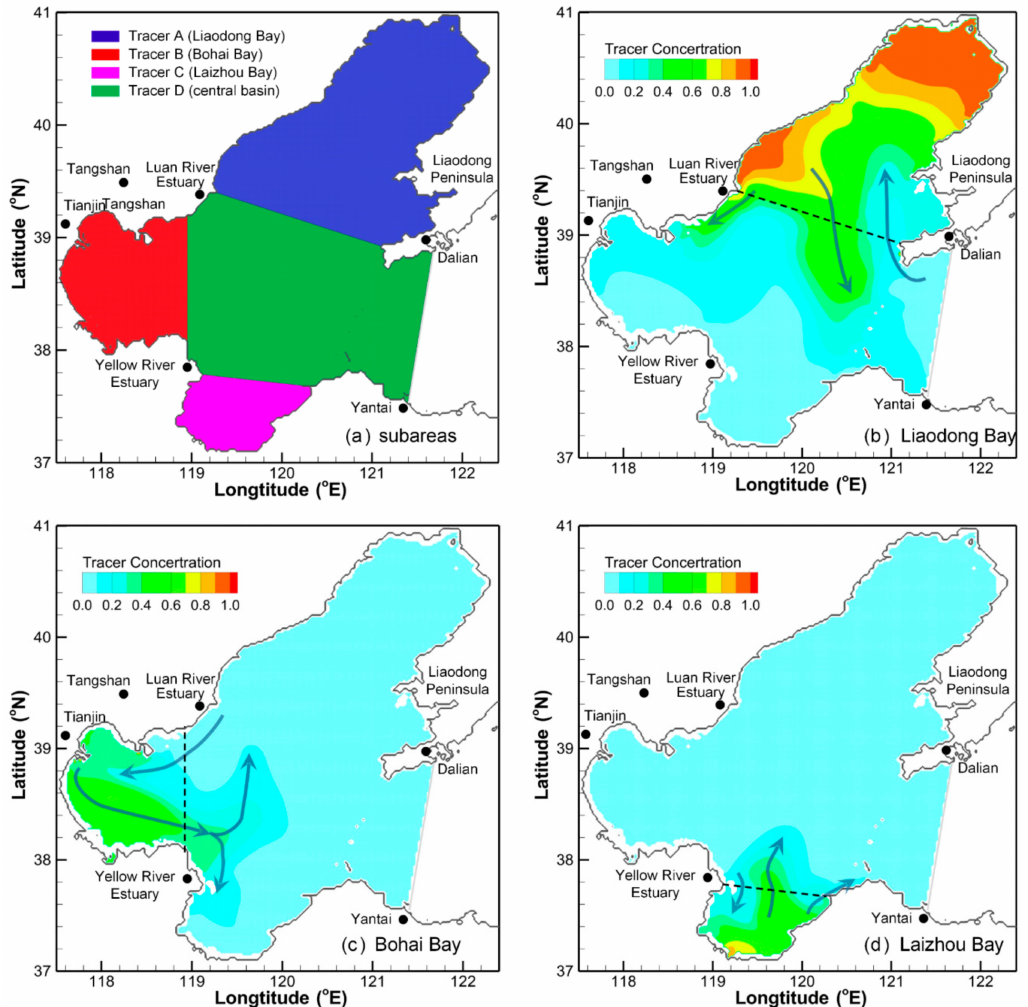
Figure 8. Tracer distribution. ( a ) Initial condition of the marked tracers (the colors represent the kind of the tracer). The concentrations of the tracer after one year of simulation (the end of 2009) in ( b ) Liaodong Bay (Tracer A), ( c ) Bohai Bay (Tracer B), and ( d ) Laizhou Bay (Tracer